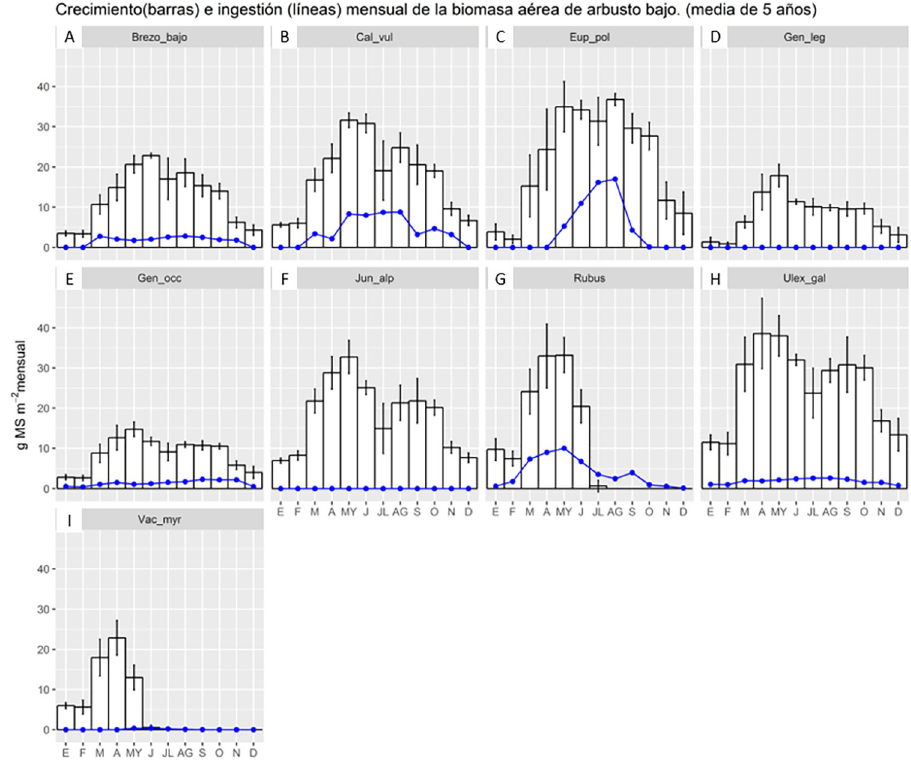
Fig 8. Example of Puerto output. Puerto can display results as images produced in R software (in Spanish language by default); this example shows the 5-yearly mean of scrubland vegetation growth (blue line) and livestock vegetation ingested (white bar) by month and type of vegetation. General title: Monthly growth (bar) and ingestion (line) of scrubland vegetation (5-year mean). Graph title: Abbreviated scientific name of scrub species. A: Erica Vagans , B: Calluna vulgaris , C: Euphorbia Polygalifolia , D: Genista legionensis , E: Genista occidentalis , F: Juniperus alpina , G: Rubus ulmifolius , H: Ulex gallii , I: Vaccinium myrtillus . X-axis: Grams of solid material by square meters and month. Y-axis: Month from January to December. White bar: Scrubland vegetation growth. Vertical line in each bar indicates the range between maximum and minimum scrubland vegetation growth during the 5 year by month. Blue line: Livestock vegetation